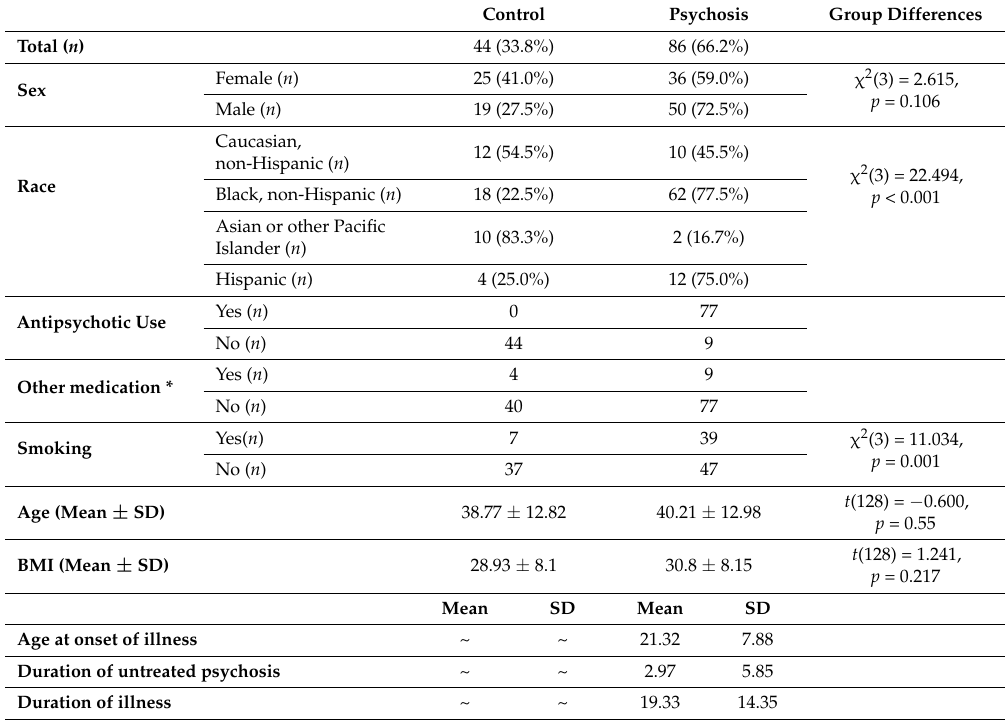
Table 1. Participant demographics for the control group and all participants with